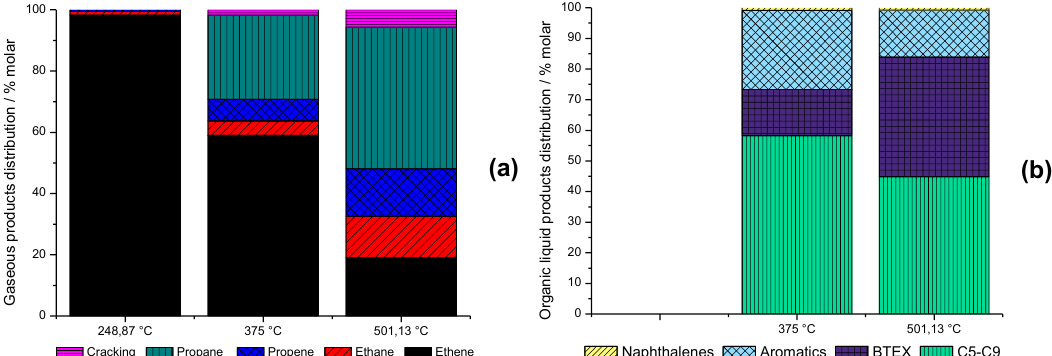
Figure 8. Product class distribution of the ( a ) gaseous fraction and ( b ) organic liquid fraction for 10 bar, 35 h − 1 , 3 h TOS, and temperature from 249 °C to 501 °C.